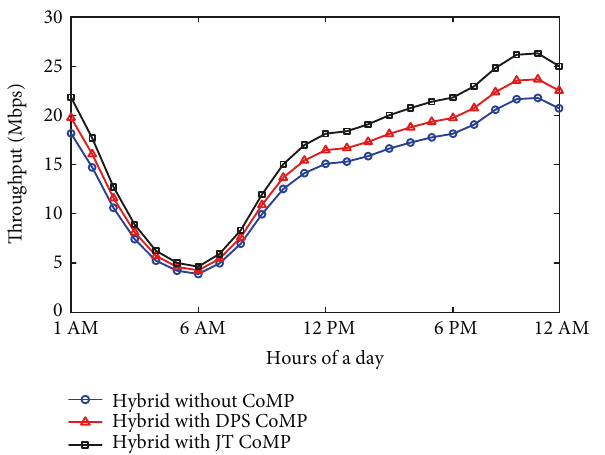
Figure 5: Throughput comparison of a single BS among the di ff erent hybrid models.